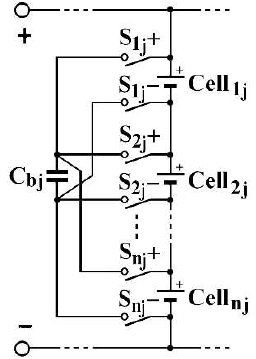
Figure 8. Balancing circuit for an SP architecture’s column j.